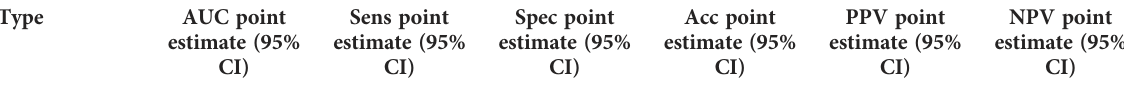
TABLE 6 Performance of the 10-variable model during external